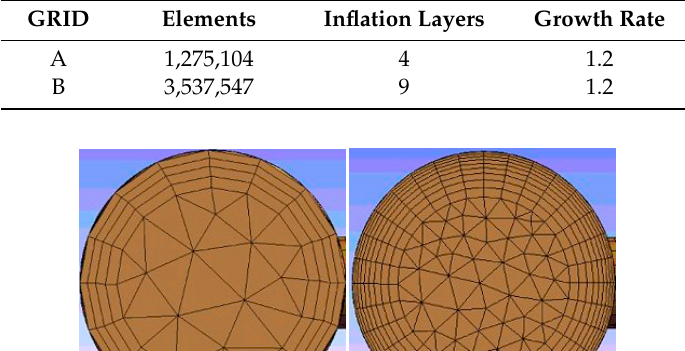
Table 2. Characteristics of the two grids created for the simulations.